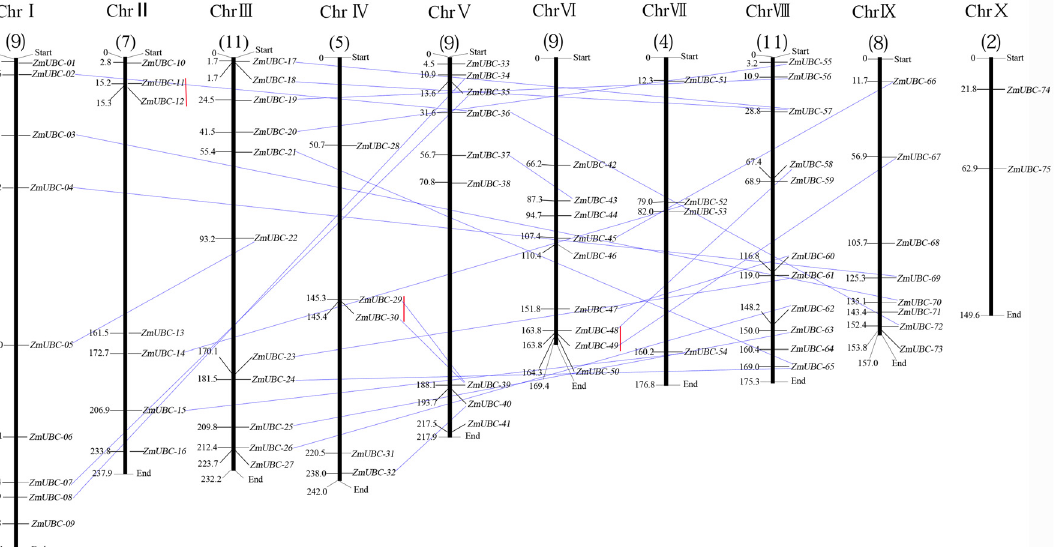
Fig 1. Chromosomal and gene duplication events involving ZmUBC genes. The chromosomal position of each UBC-encoding gene was mapped to the maize genome. The chromosomal number is indicated at the top of each chromosome. The number below represented the number of UBC-encoding genes in each chromosome. The segmental duplication genes are connected by a blue straight line. The tandemly duplicated genes are linked by a red straight line. Chromosomal distances are in Mbp.